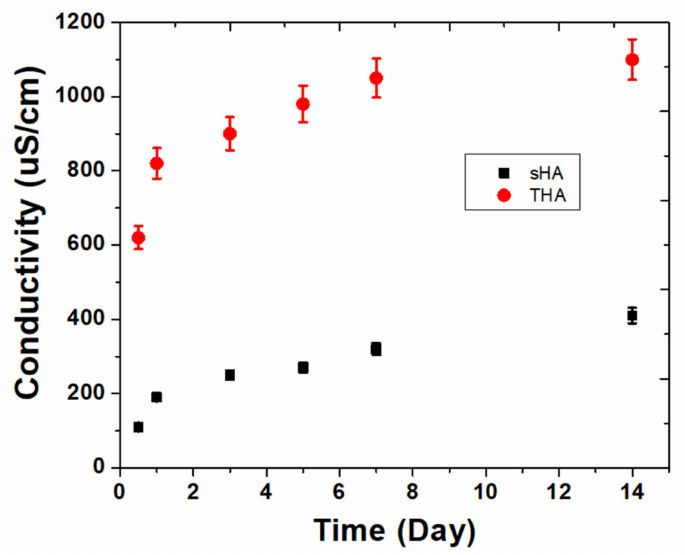
Figure 7. Electrical conductivity of the ions released from sHA and THA